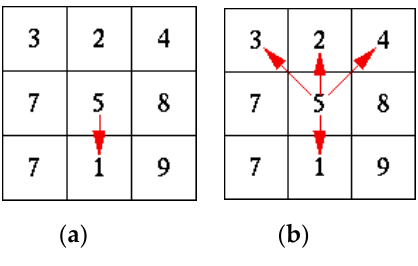
Figure 2. ( a ) Single flow direction. ( b ) Multiple flow direction.